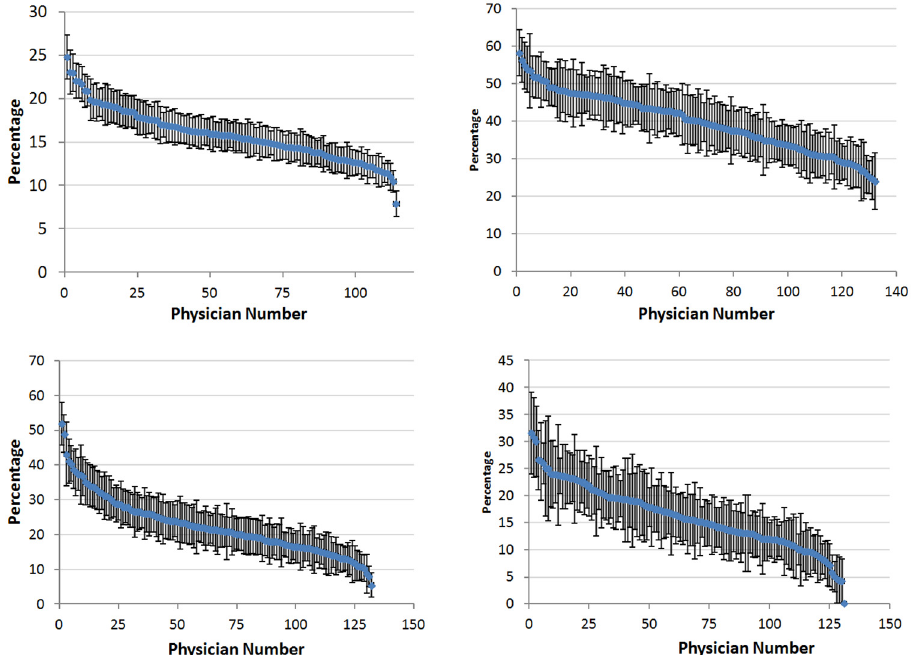
Fig 1. a-d. Percentage of patients with a beta-lactam allergy (Fig 1a), with a specific beta-lactam allergen identified (Fig 1b), with characteristics of a beta-lactam reaction documented (Fig 1c) and with a high risk beta-lactam reaction documented (Fig 1d) by high volume primary care provider panels. Binomial distribution was assumed to generate confidence intervals.